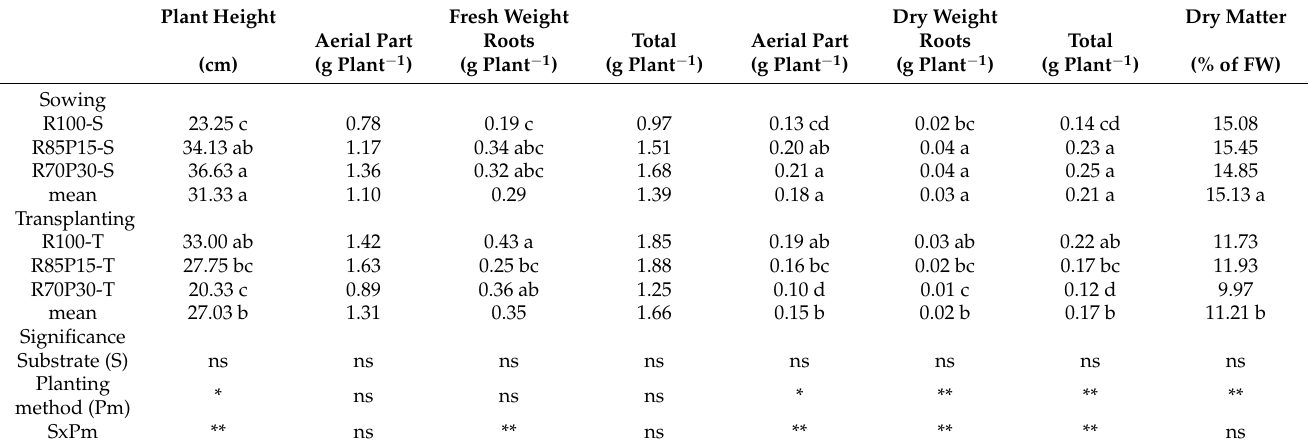
Table 1. Main growth parameters in plants of soybean cultivar ‘Pr91M10 (cid:48) grown on Mojave Mars Simulant MMS-1 (R100) alone and in mixture with peat at two different rates ( v : v ), 85:15 (R85P15) and 70:30 (R70P30), from direct sowing on the different substrates and from transplanting after germination on peat. 20 DAS; Mean values, n = 4; Different letters indicate significant differences within each column ( p < 0.05); ns, *, ** indicate non-significant or significant difference at p < 0.05 or 0.01, respectively (two-way ANOVA, Duncan’s multiple-range test).